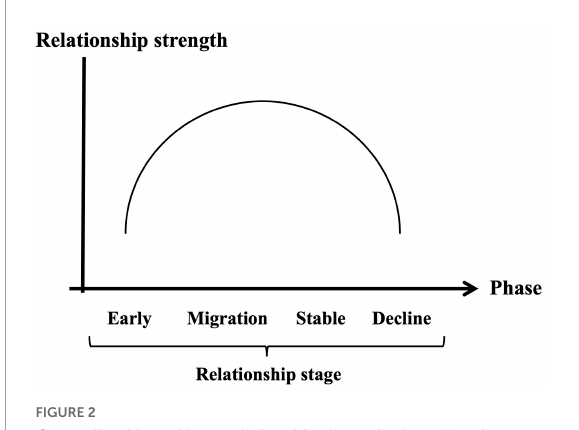
FIGURE2 Generalized brand love relationship dynamics based on inverse U-shape